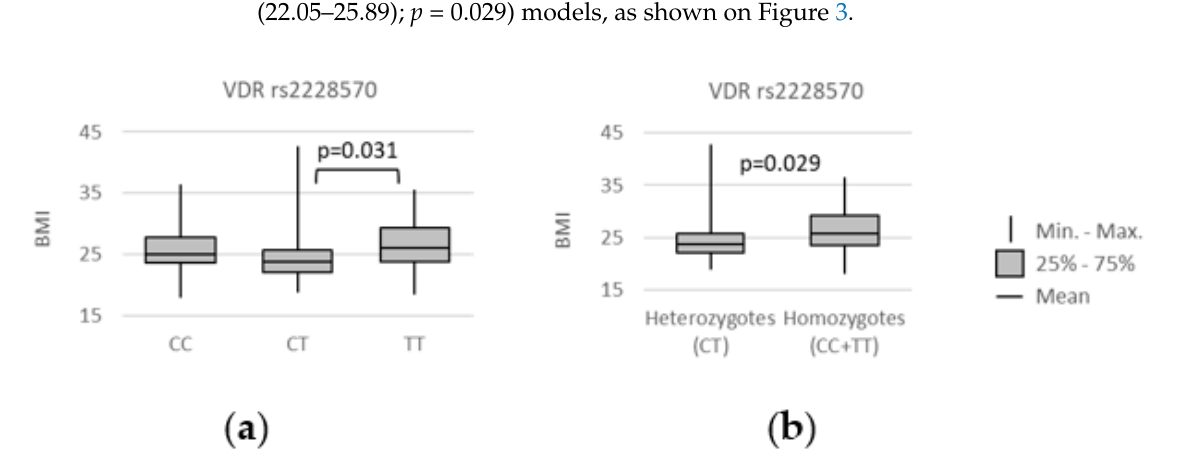
( b ) Figure 2. Relationship between VDR rs731236 genetic variants and patients’ gender. The following statistically significant associations were found: ( a ) CT vs. TT , p = 0.035, OR(95%CI) = 3 (1.16 to 7.56); and ( b ) CC + TT vs. CT , p = 0.026, OR(95%CI) = 0.35 (0.14 to 0.85). Analysis was performed using Fisher‘s exact test. 3.3. VDR Polymorphisms and Patients’ Characteristics